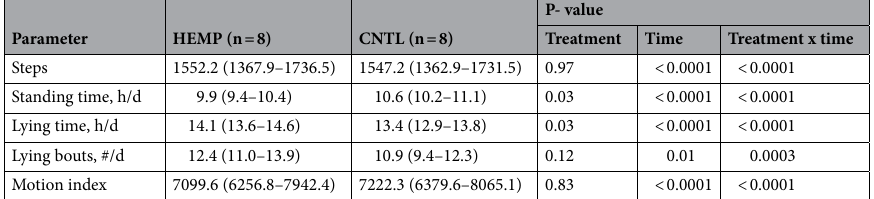
Table 3. Summary of mean (95% confidence interval) accelerometer data over 24 h intervals for cattle fed industrial hemp once a day for 14 days (HEMP) or control cattle (CNTL).